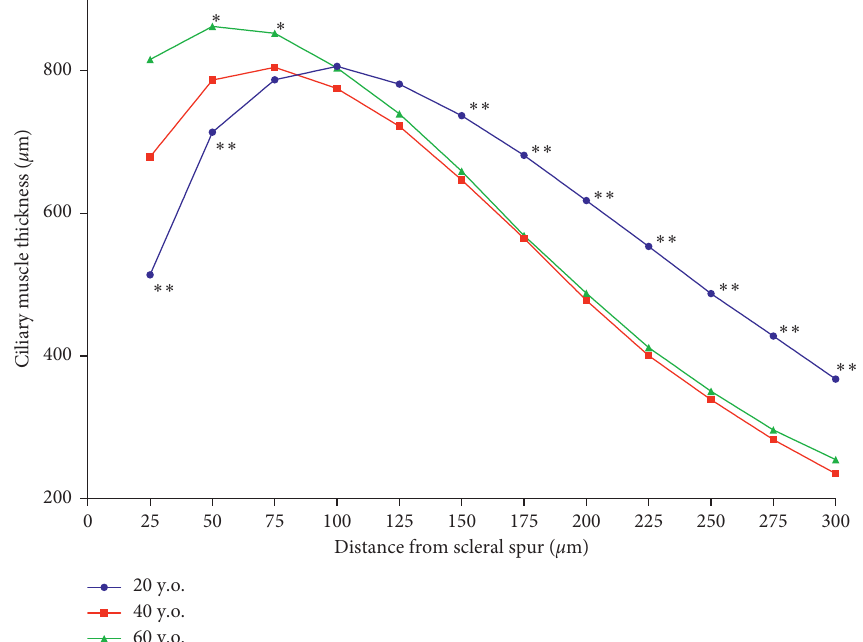
Figure 3: Ciliary muscle thickness in age groups of 20 y.o., 40 y.o., and 60y.o. while nonaccommodating. The ciliary muscle of the 60y.o. group was thicker within 75 μ m of the scleral spur compared to the 20y.o. and 40y.o. groups. The ciliary muscle of the 20y.o. group was thinner up to 50 μ m from the scleral spur and thicker at distances of 125–300 μ m from the scleral spur compared to the 40y.o and 60y.o. groups ( ∗∗ p < 0.00001), using linear mixed-effects models ( ∗ p <